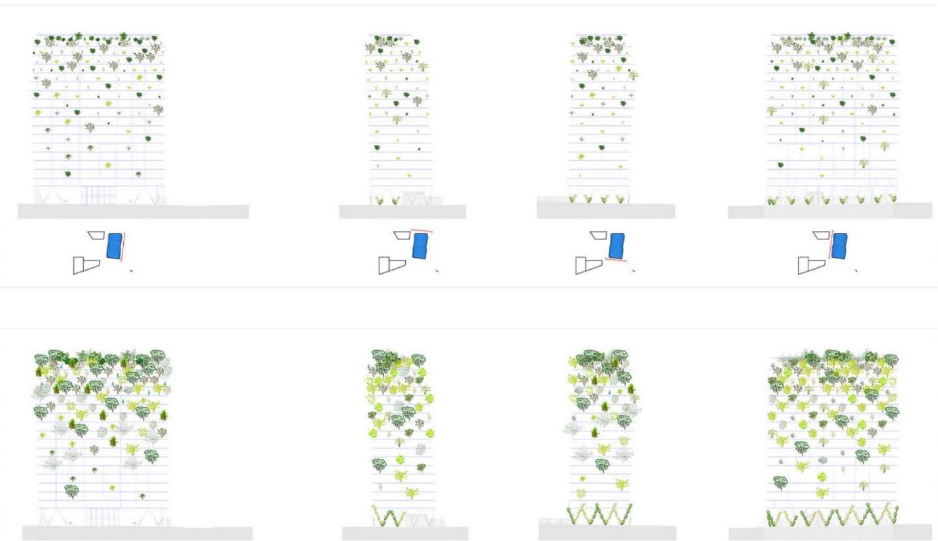
Figure 3. Expected plant growth and facade cover by the architects in the first year ( top ) and 10–15 years after completion ( bottom ) and each façade orientation; east, north, south and west (from left to right). The façade orientation is also marked with a red line in the plan in the middle of the figure according to each façade face. The tour de la biodiversité is the blue marked building in the plan. (Maison Edouard Francois 2016).